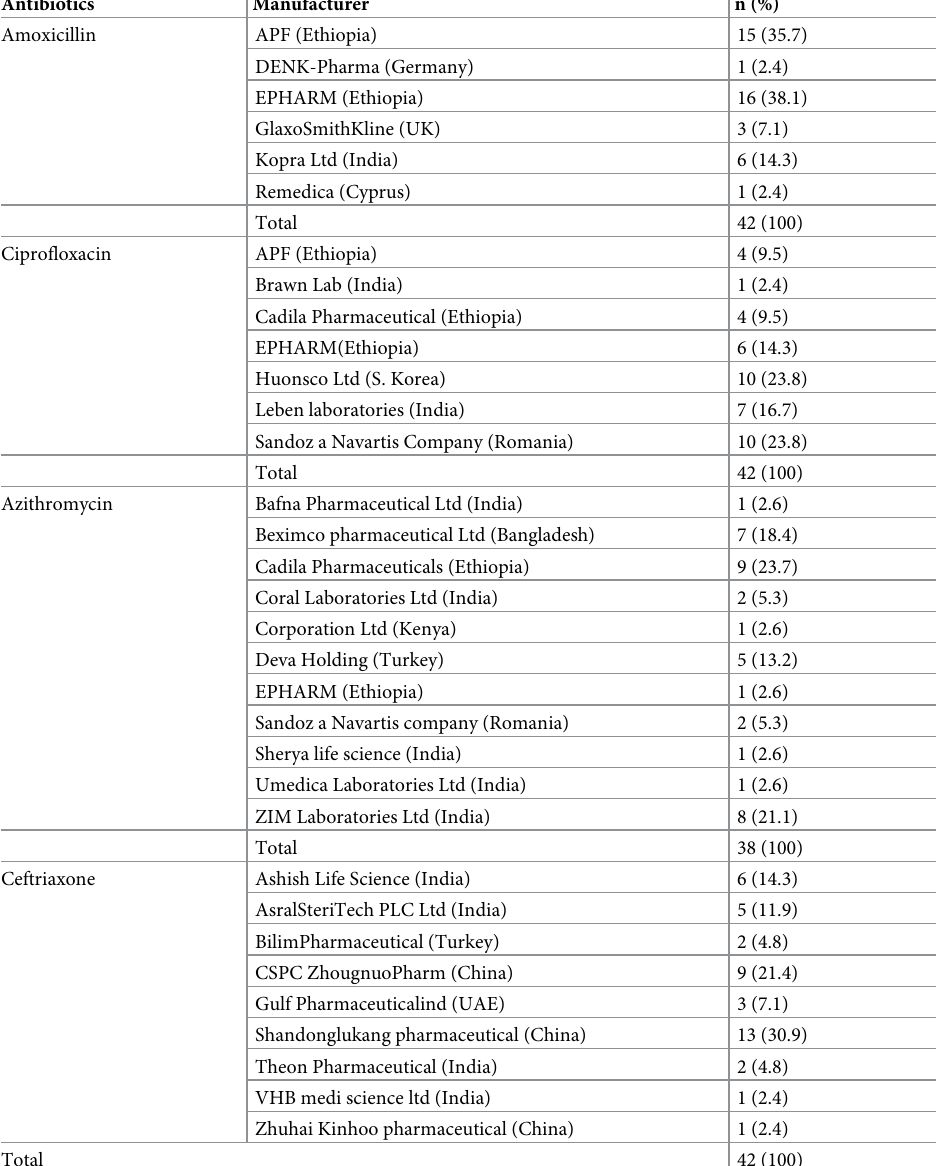
Table 2. Frequency of antibiotics based on manufacturers at Adama, Ethiopia, March 2018 to June